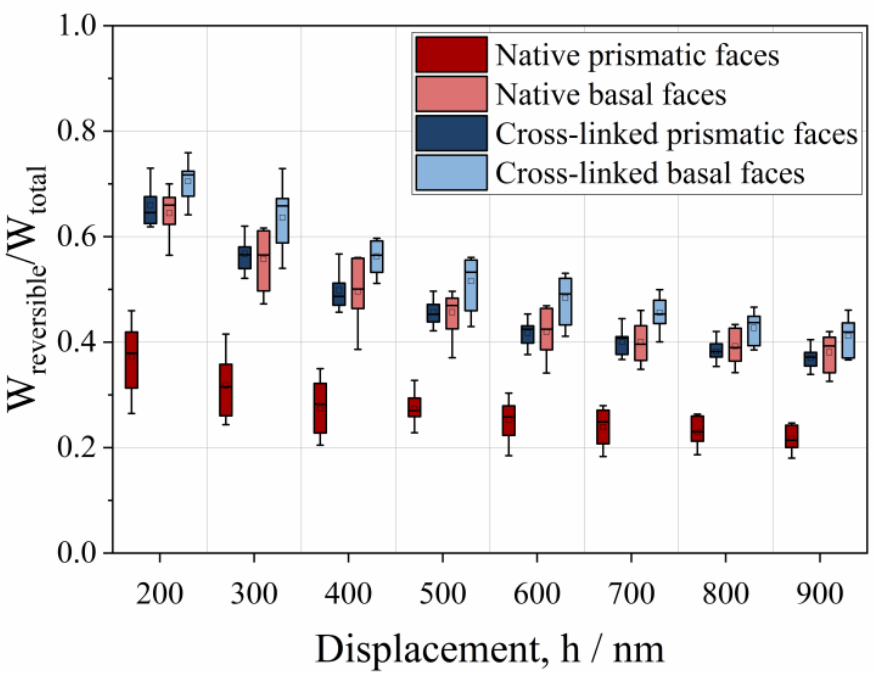
Figure 11. Fraction of the reversible indentation work of native and cross-linked enzyme crystals as a function of penetration depth.